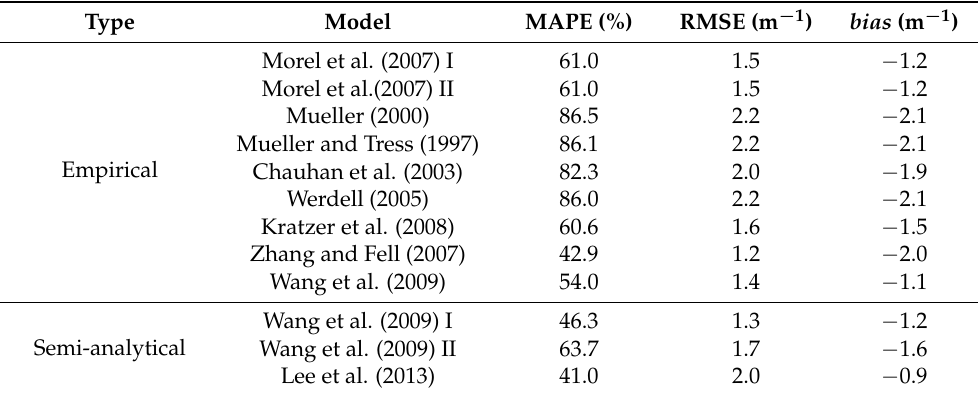
Table 3. Error assessment of k d (490) models developed for clear, slightly turbid, turbid ocean waters, coastal waters and global waters applied to all dataset of